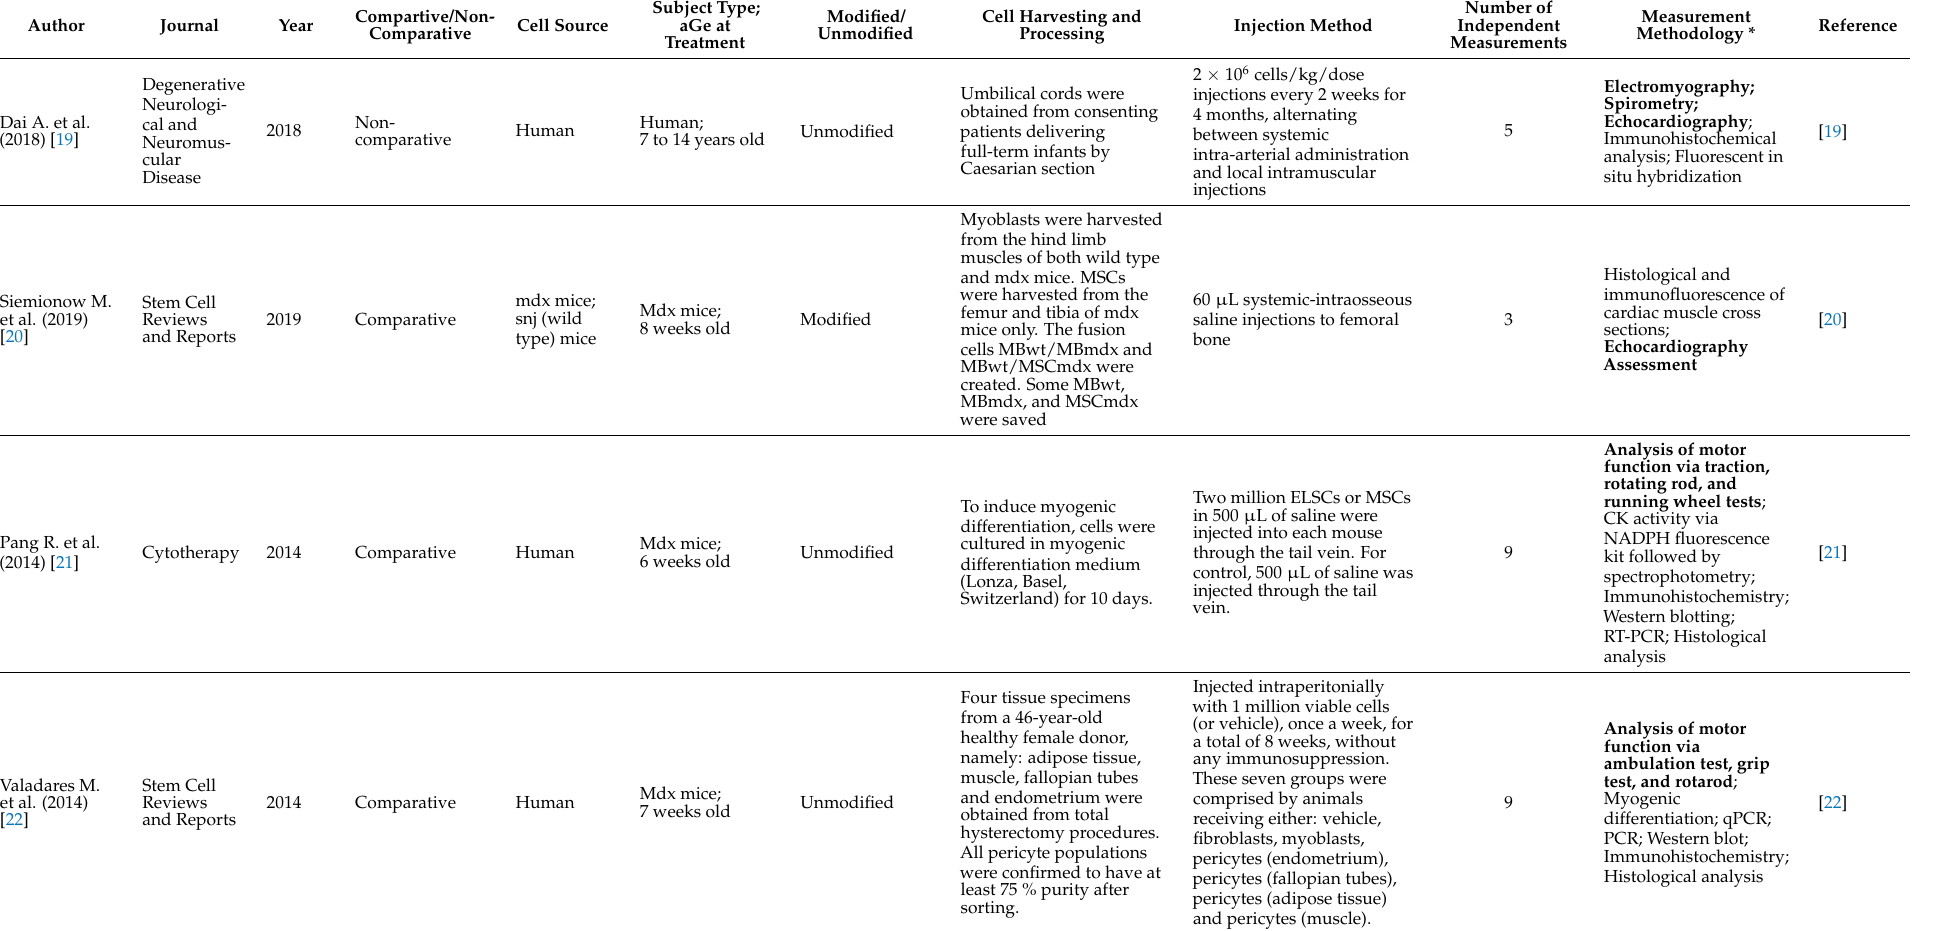
Table 3. Characteristics of selected